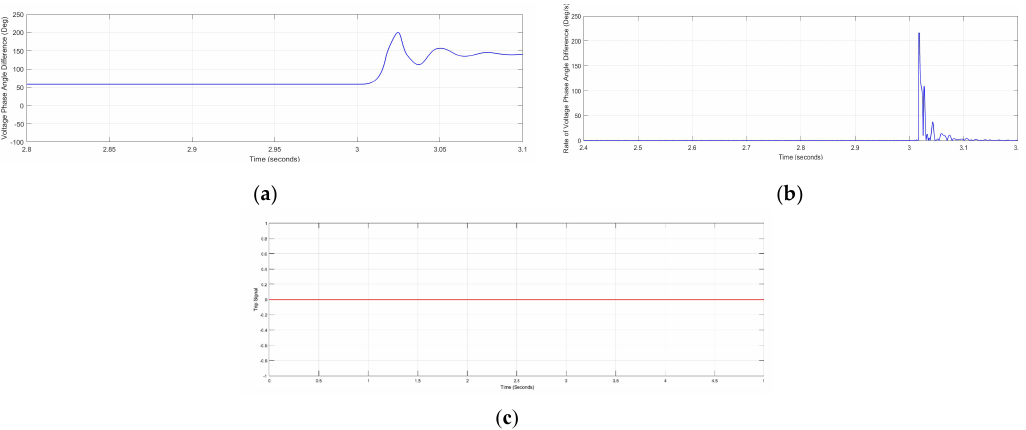
Figure 14. Results of case (vi) Starting of Industrial Motor Loads. ( a ) Voltage phase angle difference; ( b ) Rate of change of voltage phase angle difference; ( c ) Trip Signal.